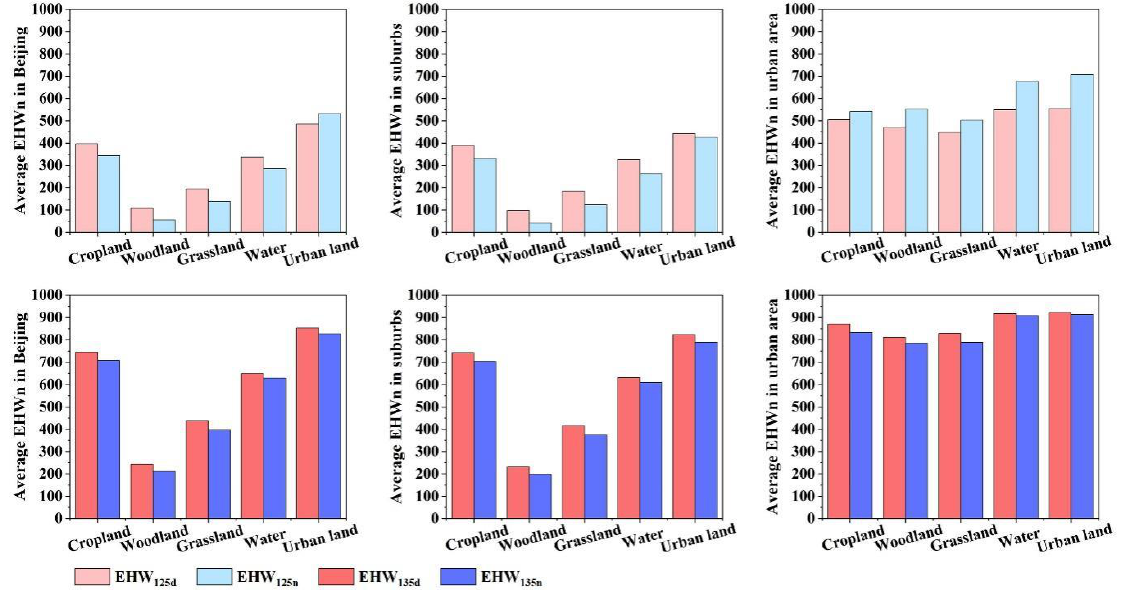
Figure 4. The average values of EHW 125d , EHW 125n , EHW 135d , and EHW 135n for each land-use type in the whole Beijing, Be ijing’s urban areas, and Beijing’s